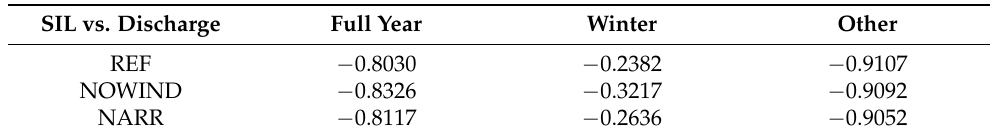
Figure 3. Time series of the year 2014 for the reference simulation: ( a ) river discharge at Bonneville; ( b ) tidal range at SATURN − 03; ( c ) along-estuary wind stress τ x from the reference simulation (with WRF4); ( d ) Mixing and Froude number at cross-section of Point Adams; ( e ) maximum (tidal day) salinity intrusion length from model results (REF, NARR, and NOWIND) vs. X 2 computed from river discharge (X2Q), by using the method described by Monismith et al. [48]. The yellow vertical bands indicate the peaks of along-estuary wind stress, while the gray area highlights the period during which the river discharge and, consequently, the Froud number are increasing up to their maximum. Table 2. Correlations between river discharge and salinity intrusion length (SIL), computed for different periods of the year 2014. Winter represents the months of January–February–November– December, while Other is the rest of the